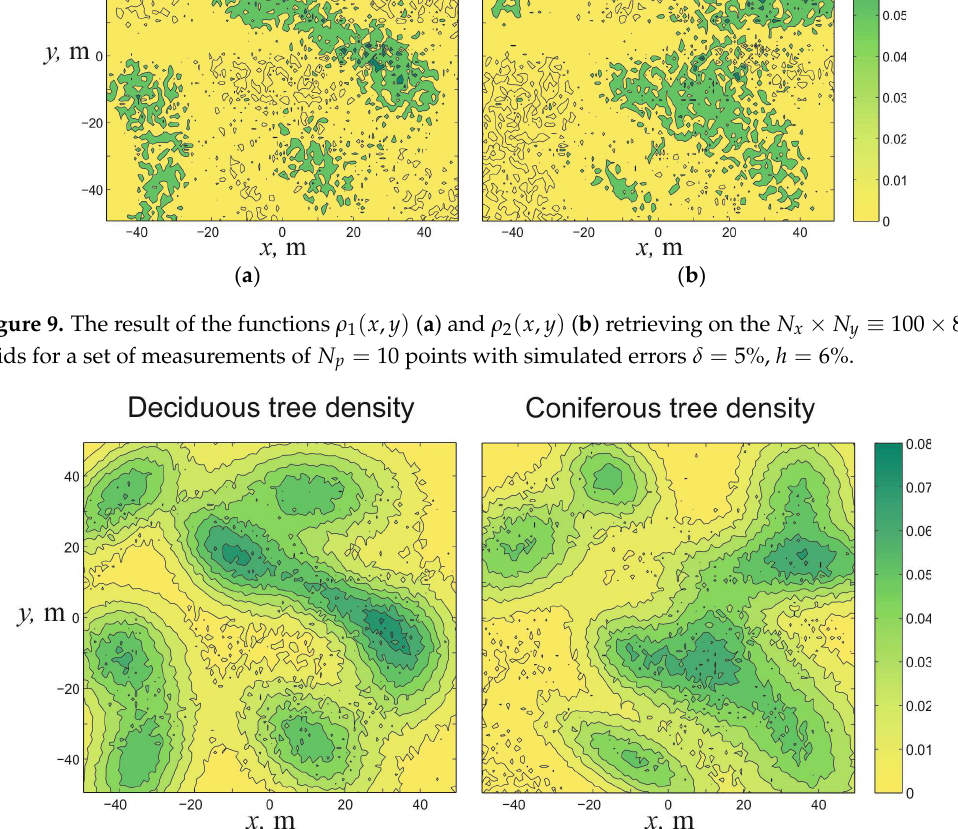
Figure 10. The result of the functions ρ ( x , y ) ( a ) and ρ ( x , y ) ( b ) retrieving on the N x × N y ≡ 100 × 80 2 1 grids for a set of measurements of N p = 500 points with simulated errors δ = 5%, h = 6%.